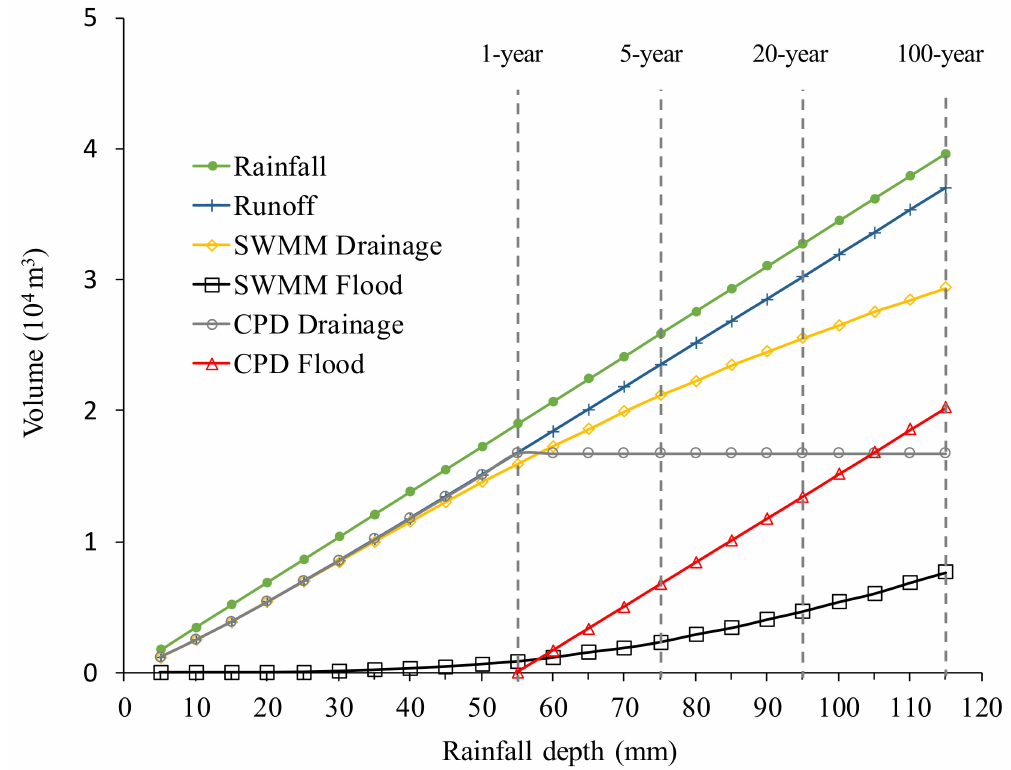
Figure 3. Hydrological responses of the drainage network DN6 simulated by the SWMM and the CPD under the rainfall events from 5 to 115 mm. Four typical return periods are marked using vertical dashed lines. The key properties of DN6 are: (1) area, 34.4 ha; (2) imperviousness, 75.4%; (3) pipe length, 1.45 km; (4) average pipe slope, 0.76%; (5) average pipe cross section area, 0.371 m 2 ; and (6) average surface slope,